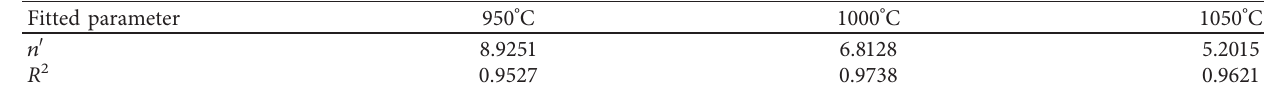
Fitted parameter